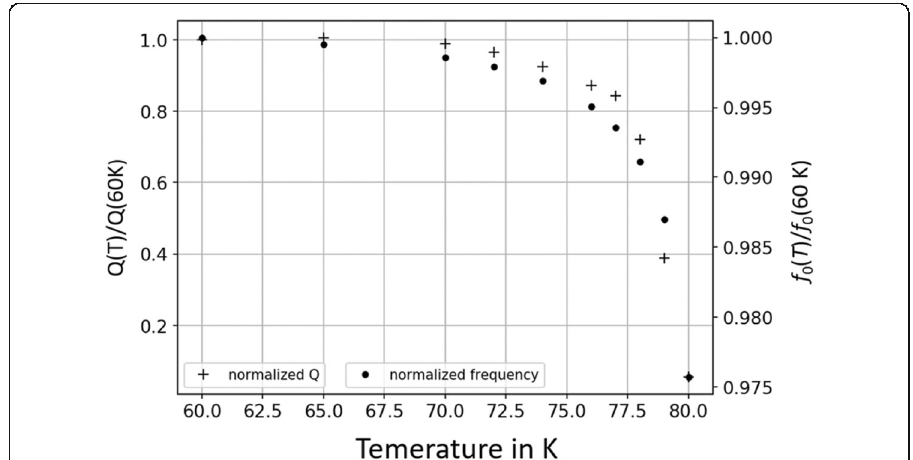
0 (T)/ f 0 (60K) (circles) as a function of the temperature probed by the